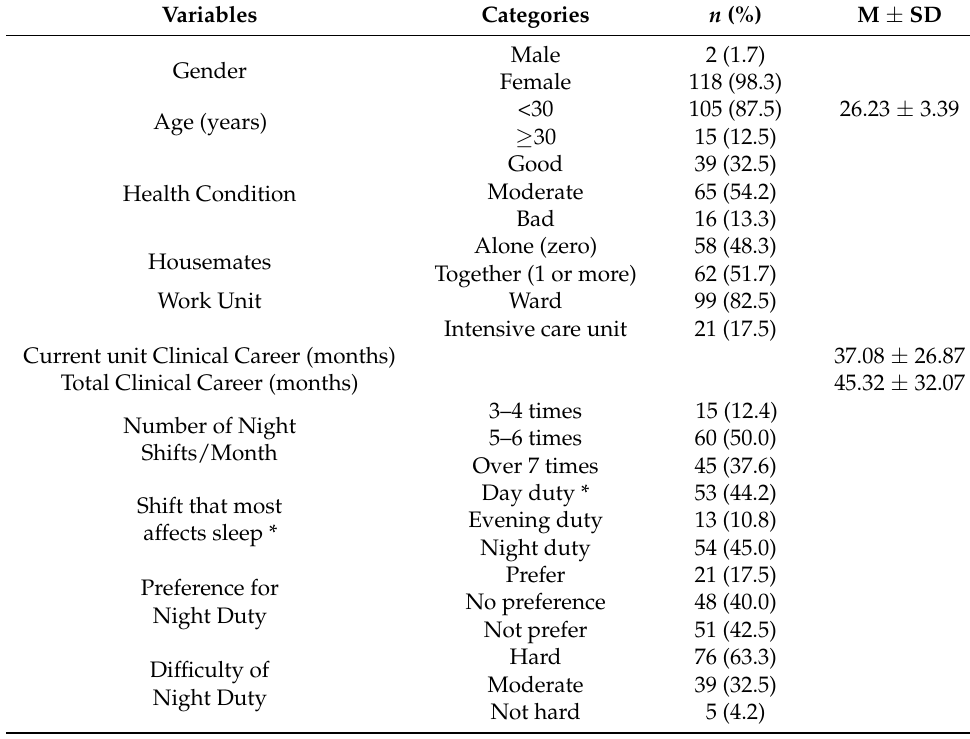
Table 1. Demographic and work-related characteristics of participants ( n =